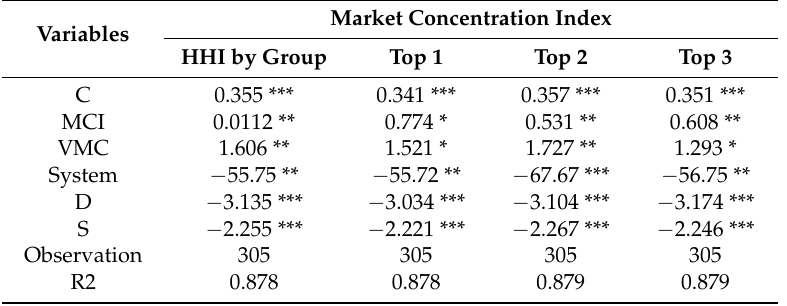
Table 3. Econometric